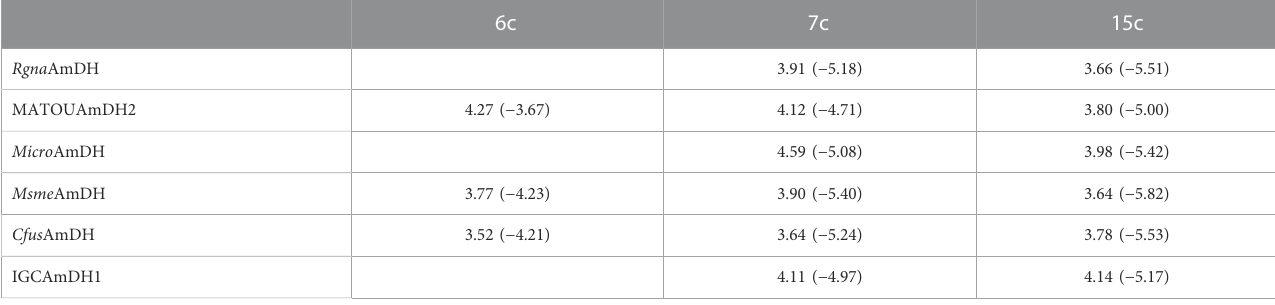
TABLE 2 C4N-C(OH) distances and related energies of the corresponding top 10 docked conformations of alcohols 6c, 7c and 15c into some studied nat-AmDHs.